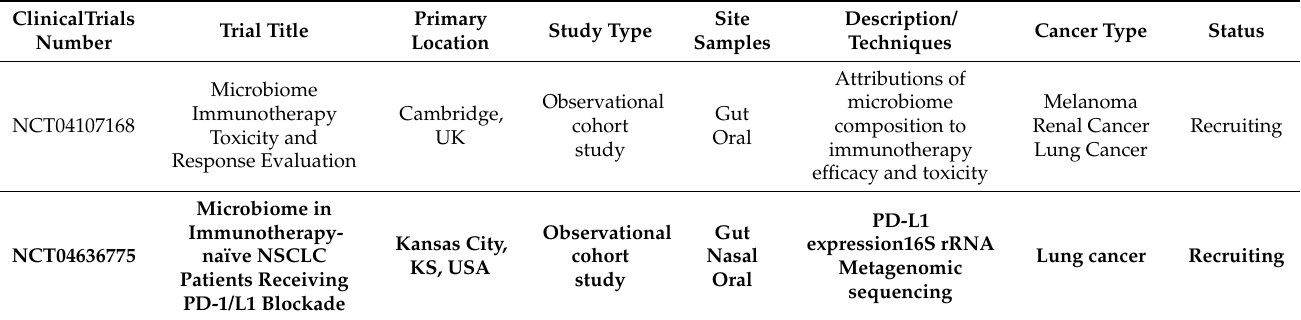
Table 1. Active studies examining microbiome and immunotherapy